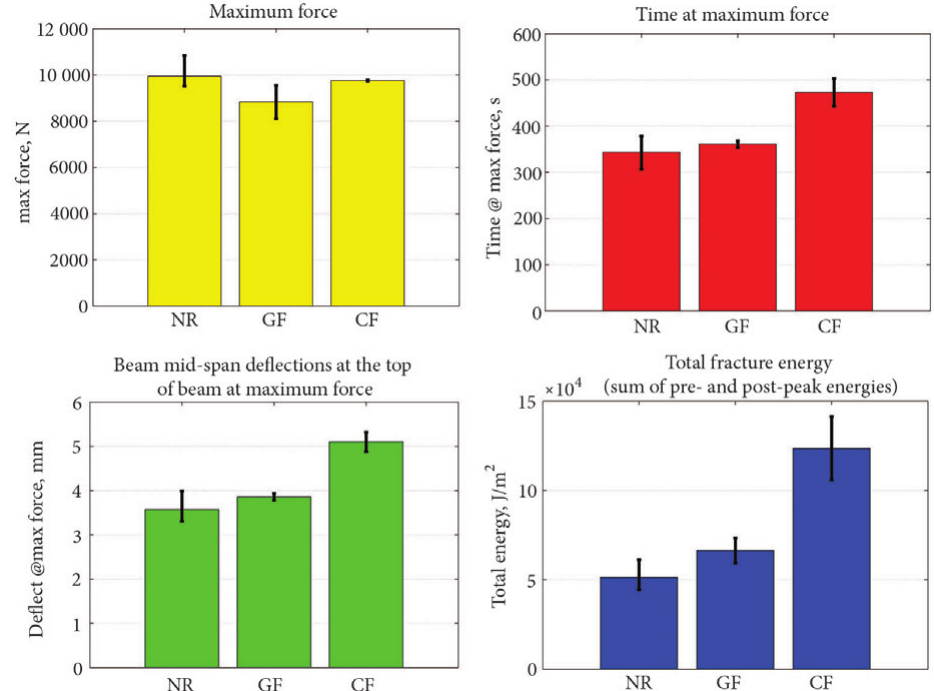
Fig. 2. Different parameters from monotonic